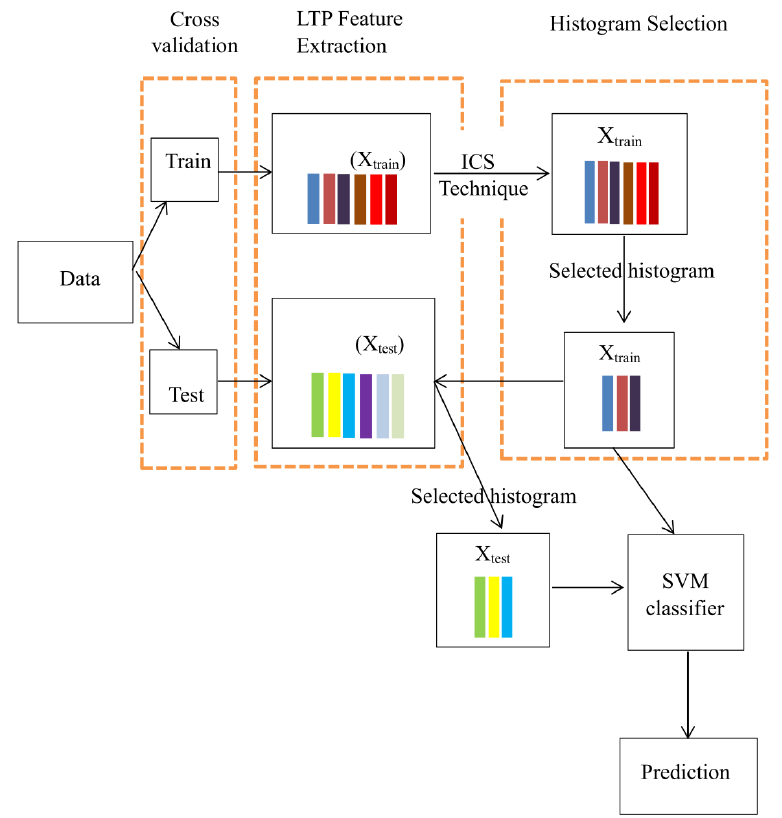
Figure 5. The cloud image classification process based on histogram selection using ICS